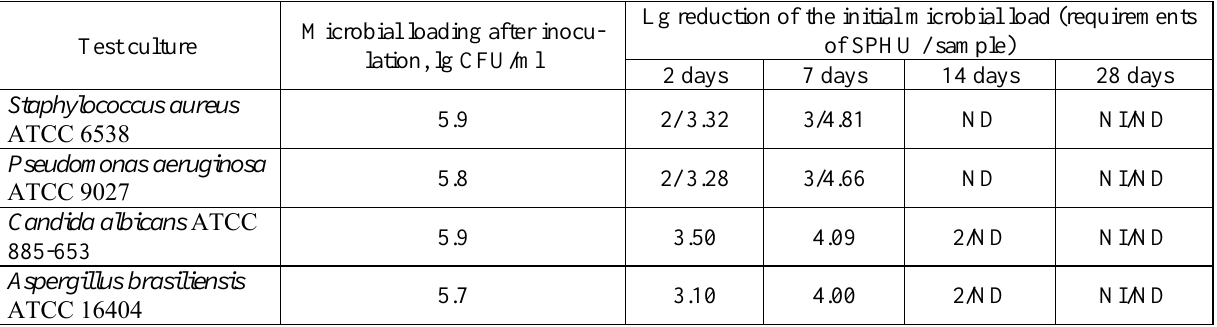
Antimicrobial efficacy of nipagin 0.2 % preservative in the gel samples under study Lg reduction of the initial microbial load Microbial loading after inocu- Test culture lation, lg CFU/ml